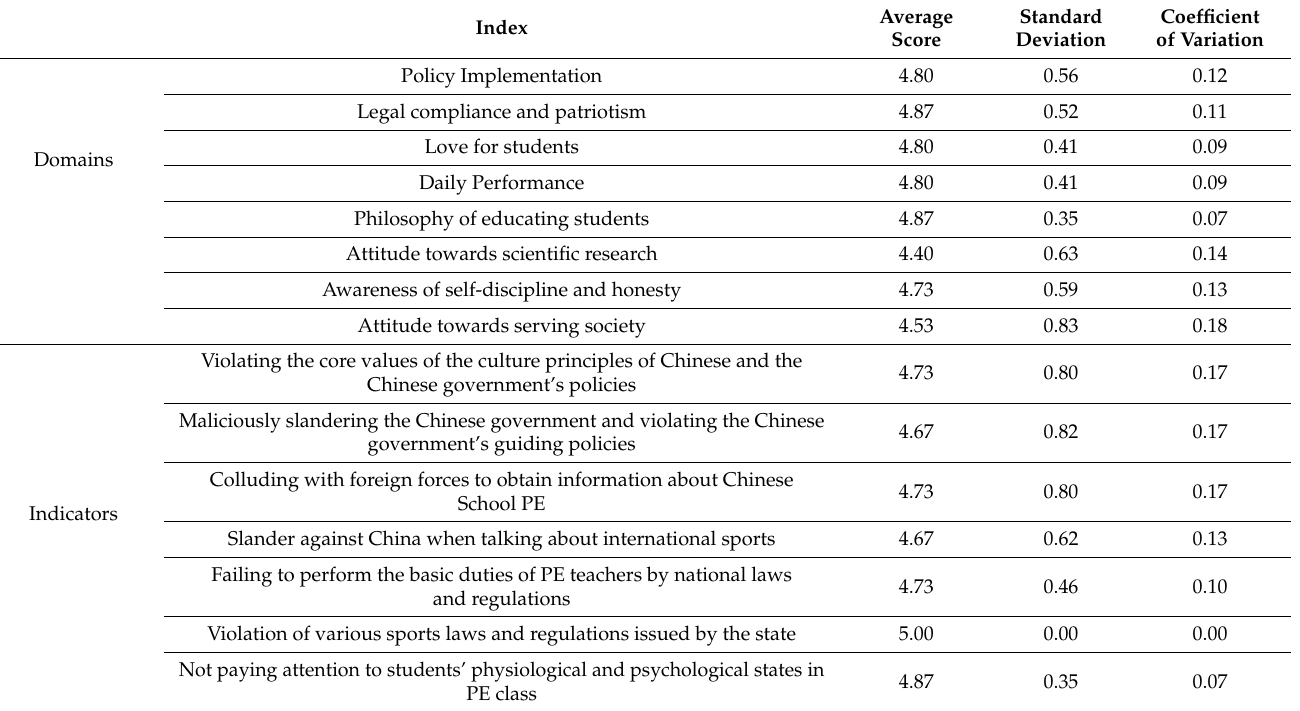
Table A1. The result of Round